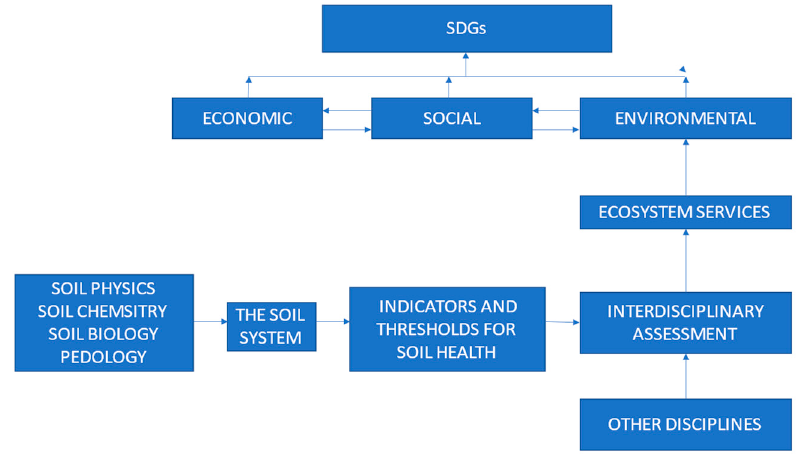
Figure 2. The various steps needed to realize soil contributions to the SDGs: integration of the various soil subdisciplines and interdisciplinary assessment defining ecosystem services that contribute to environmental aspects of the SDGs. Integration with economic and social aspects of sustainable development is essential but is beyond the direct scope of soil science.